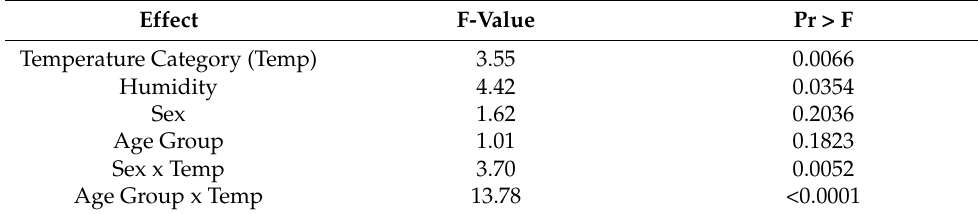
Table 2. Type III Tests of Fixed